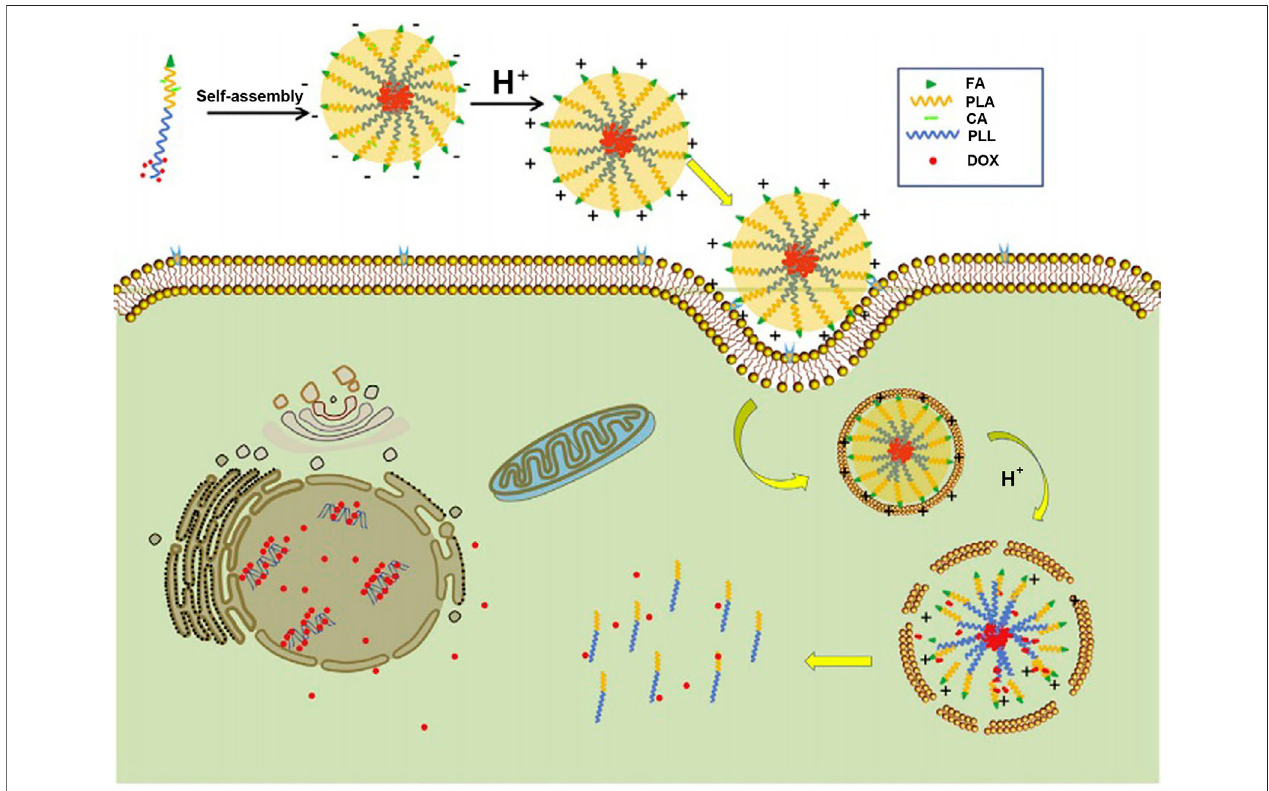
FIGURE 9 | Illustration of the folate-conjugated pH-responsive polymeric micelles based on FA – PLL(CA) – PLA for receptor-mediated endocytosis and pH- triggered release (Guan et al., 2017). Abbreviation: FA, folate; PLL, poly(L-lysine); CA, citric acid; PLA, poly(lactc acid); DOX, doxorubicin.